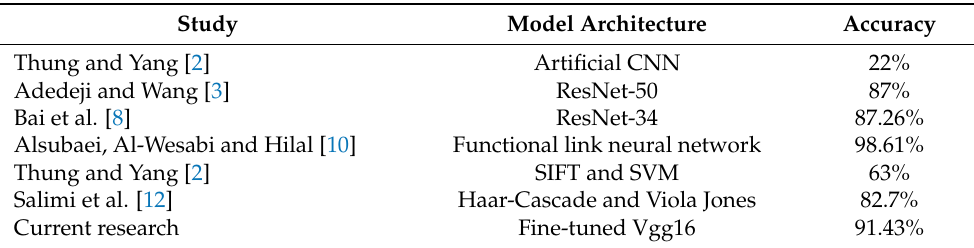
Table 3. Comparison of the classification accuracies of the trash classification models from the previous studies. Note however that each research utilized its own dataset, which adds an element of bias to the